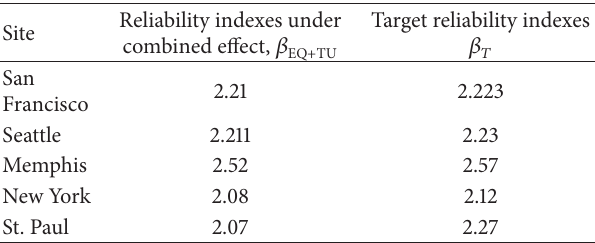
Table 6: Reliability indexes for the bending moment limit state under combined seismic and thermal loads.